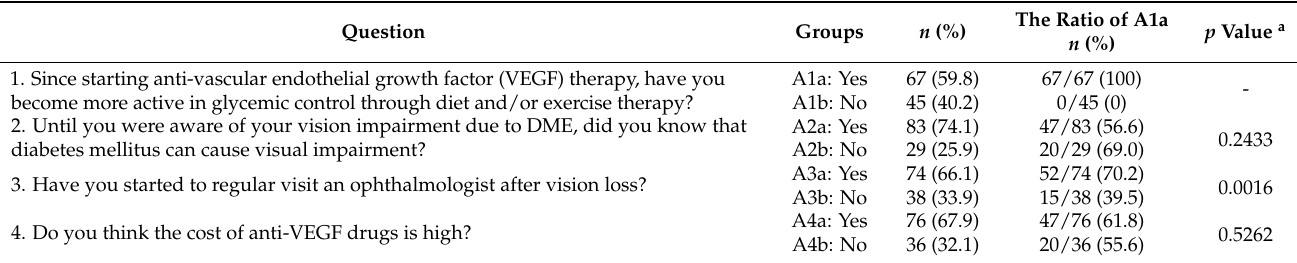
Table 2. Questionnaire structure and answer distribution.